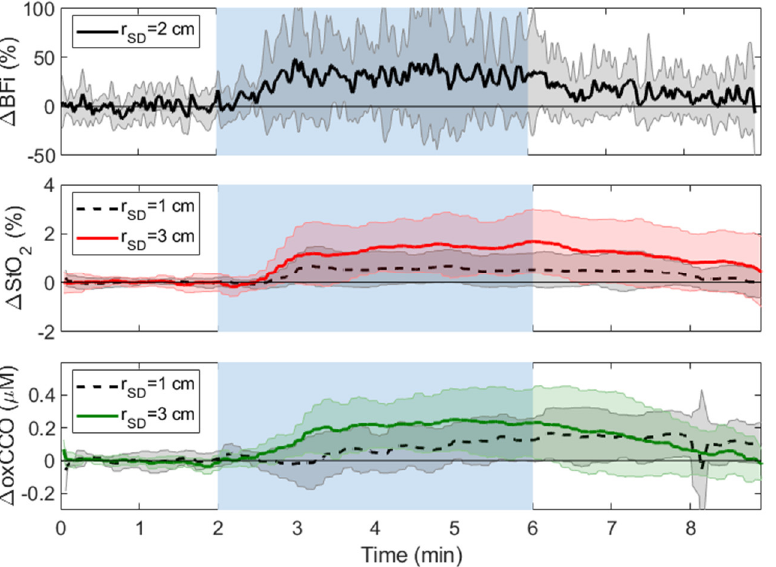
Figure 7. Average changes in BFi, StO 2 , and oxCCO in response to a 4-min hypercapnic challenge indicated by the blue shading. Time courses were averaged across subjects, and shading surrounding each line represents the standard deviation. Table 2. Average hemodynamic and metabolic changes during and following hypercapnia.